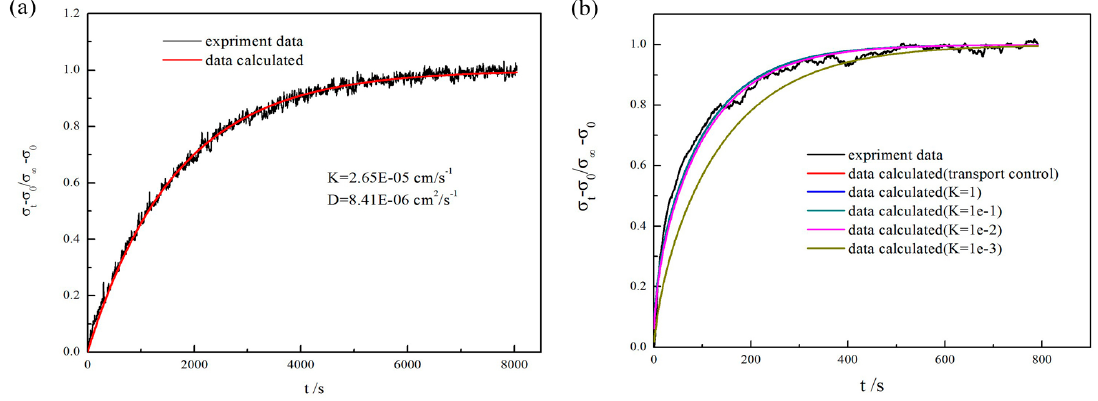
Figure 5. Experimental data and fitting curves of conductivity change profiles (750 °C) as a function of relaxation time for ( a ) the pure LSCF bar and ( b ) the LSCF bar with Ni particles by 800 °C × 60 min.